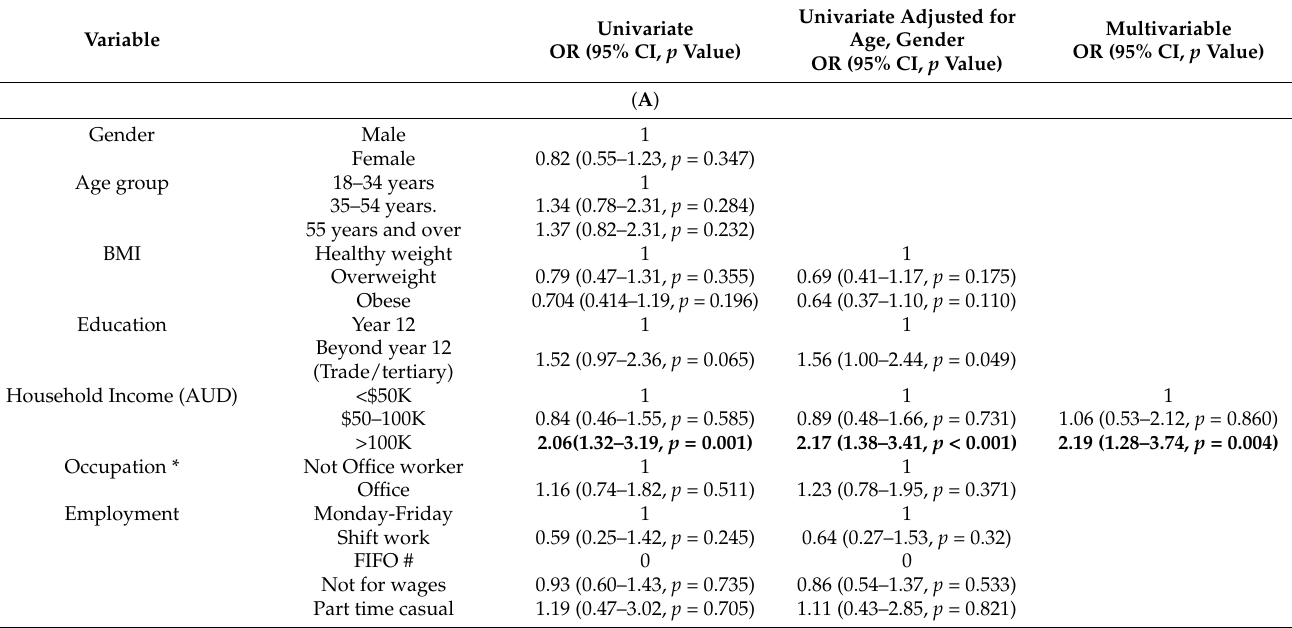
Table 3. ( A ): Logistic regression for association between sociodemographic characteristics and ‘attention paid’ to the health aspects of their diets (n= 540). ( B ) Logistic regression for association between sociodemographic characteristics and the likelihood of being concerned for sustainable household food waste and food packaging disposal (n = 540). ( C ) Logistic regression for association between socio-demographic characteristics and likelihood of considering the level of food processing (n =